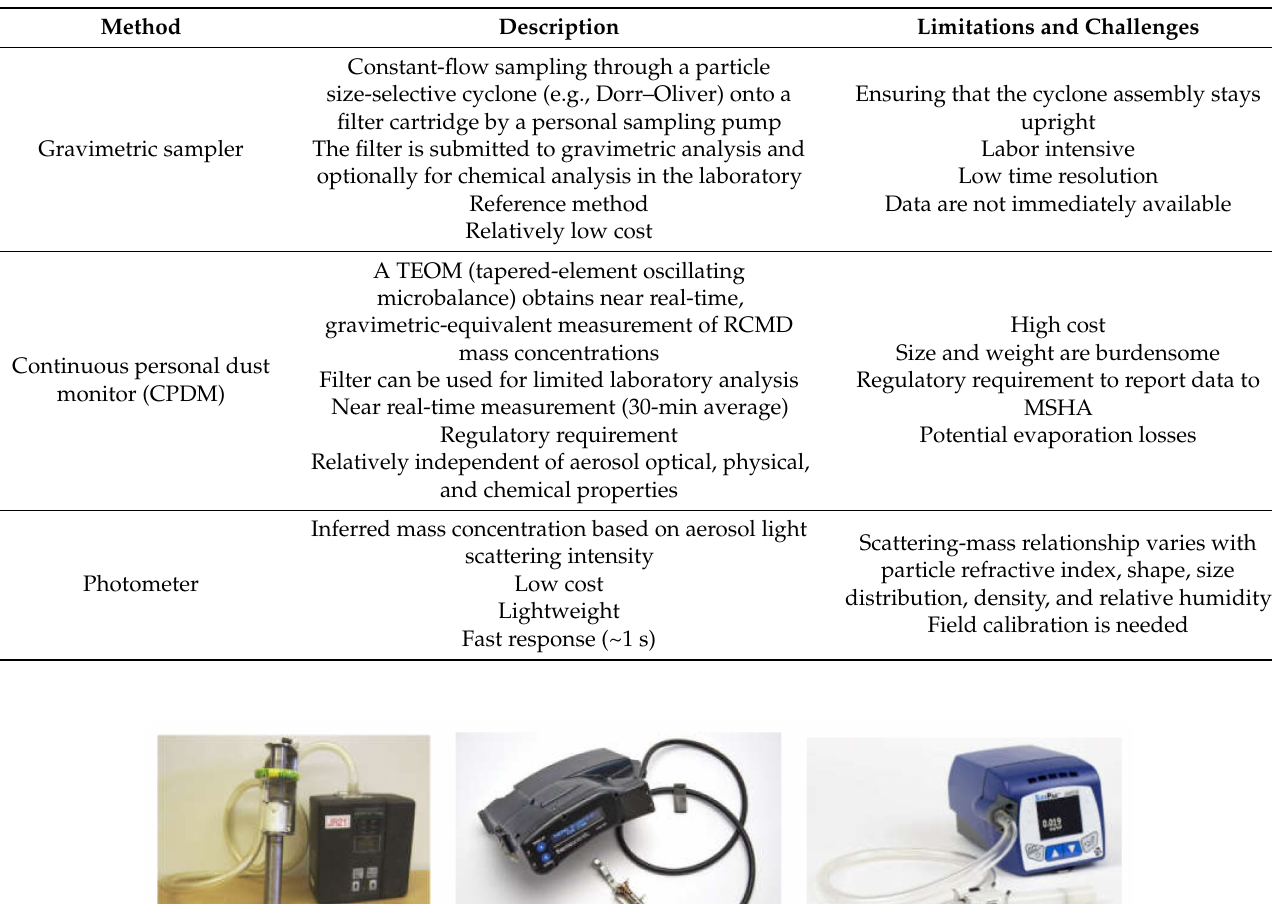
Table 1. Comparison of RCMD mass concentration measurements.